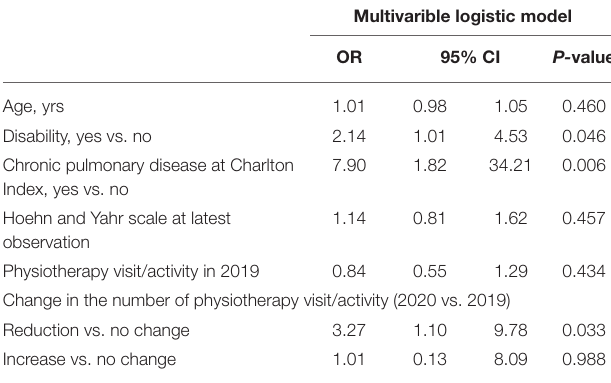
TABLE 6 | Multivariable logistic model of prognostic analysis on factors associated to the occurrence of any Parkinson’s disease related major clinical outcome in the Parkinson’s disease cohort, period June-September